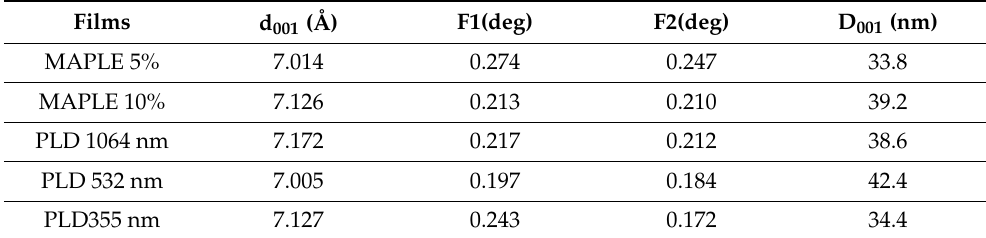
Table 4. Structural data of the films deposited via PLD and